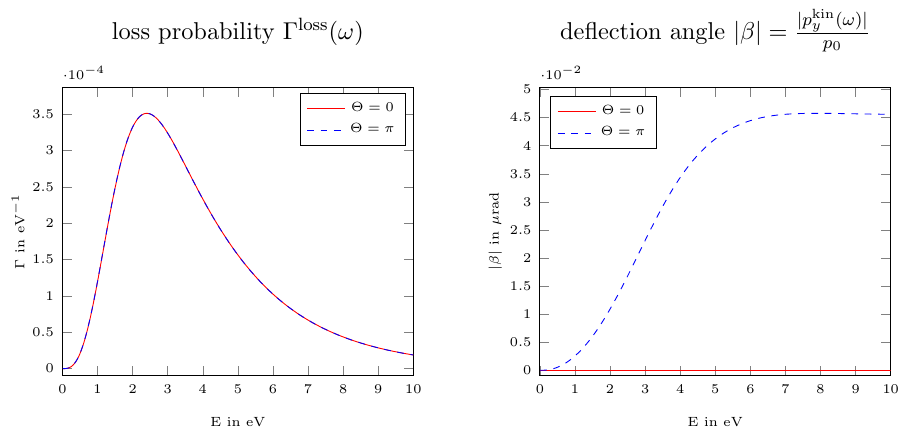
Figure 4: Loss probability Γ (left hand side) and absolute value of the deflection | / p angle | β | = | p kin (right hand side) of the exciting electron for a topological trivial 0 y (red solid curves respectively) and TI (blue dashed curves respectively) sphere with R = 50nm and ε = − 0.5. The impact parameter of the exciting electron was set to 1nm at 40keV primary energy. Note that the loss probability follows almost the same course for the topological trivial and the TI case due to the tiny contribution of the axion term to the loss probability quadratic in α .